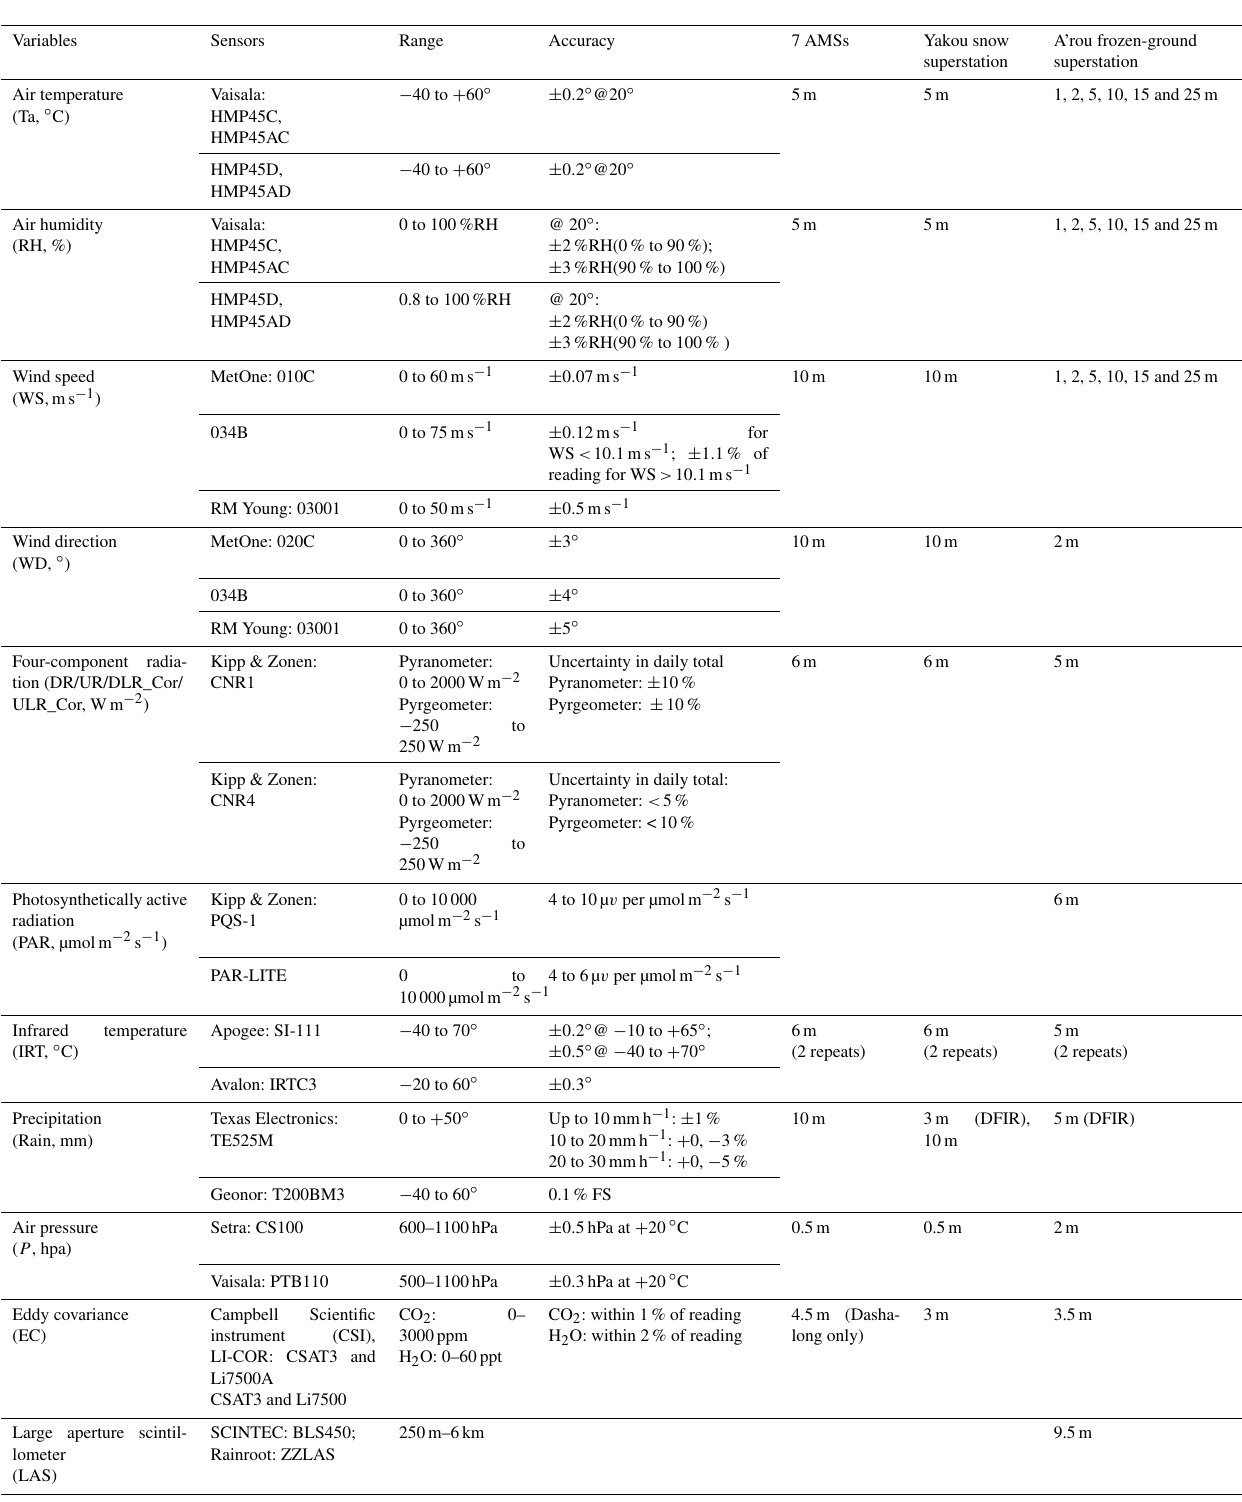
Table 2. Measuring variables, sensors and